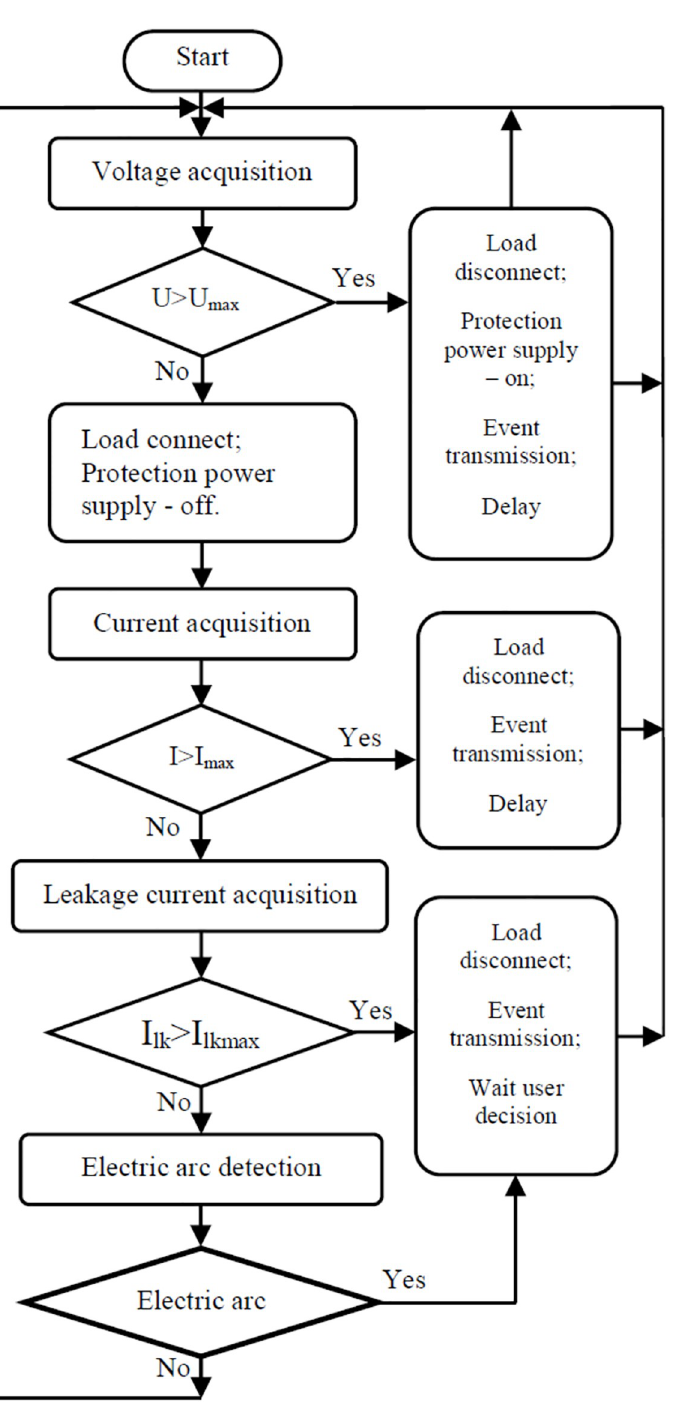
Fig 3. Embedded software control flow